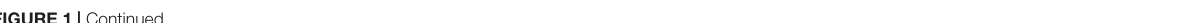
FIGURE 1 | Continued current injection of 150 pA. The summary indicative of distribution of the subicular neurons in (H) WT and (I) AS mice. No significant differences were observed in the distribution pattern of different neuronal populations in the subiculum of WT and AS mice [ χ 2 = 0.04, p = 0.84 for RF, χ 2 = 0.16, p = 0.68 for WB, and χ 2 = 0.37, p = 0.54 for SB neurons in chi-square